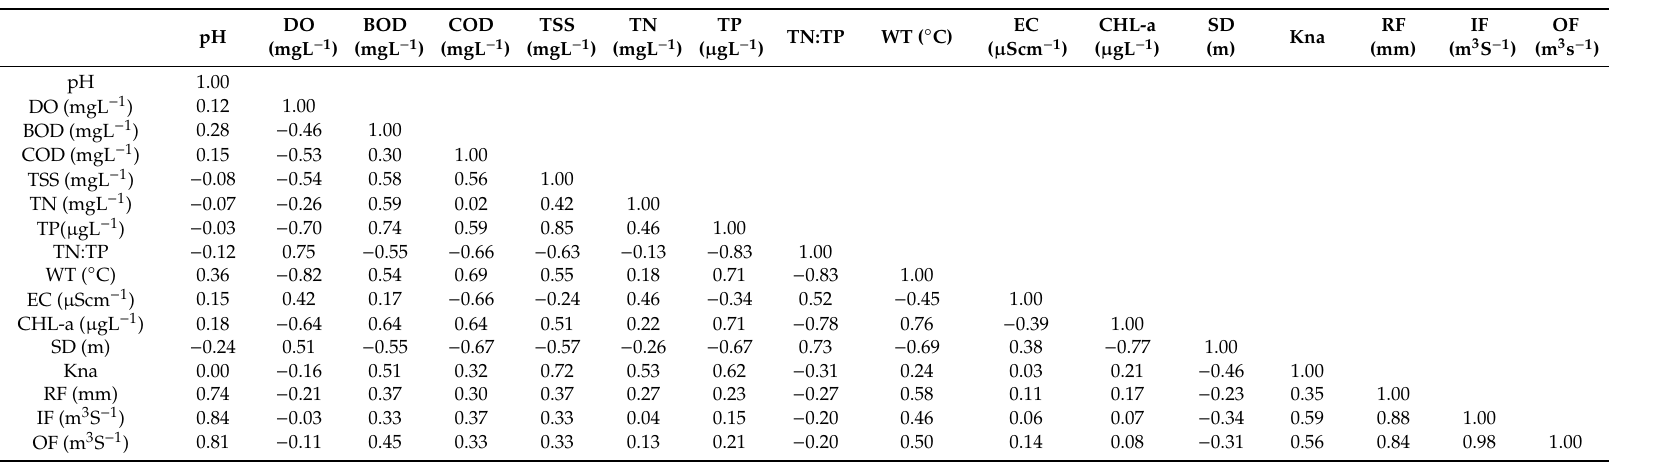
Table 2. Pearson correlation analysis of water quality parameters during 2000–2018 (pH: hydrogen ion concertation, DO: dissolved oxygen, BOD: biological oxygen demand, COD: chemical oxygen demand, TSS: total suspended solids, TN: total nitrogen, TP: total phosphorus, WT: water temperature, EC: electrical conductivity, CHL-a: chlorophyll-a, SD: Secchi depth, Kna: non-algal light attenuation coe ffi cient, RF: rainfall, IF: inflow, OF: outflow, monthly data from 2000–2018 were used to make the Pearson correlation analysis of water quality